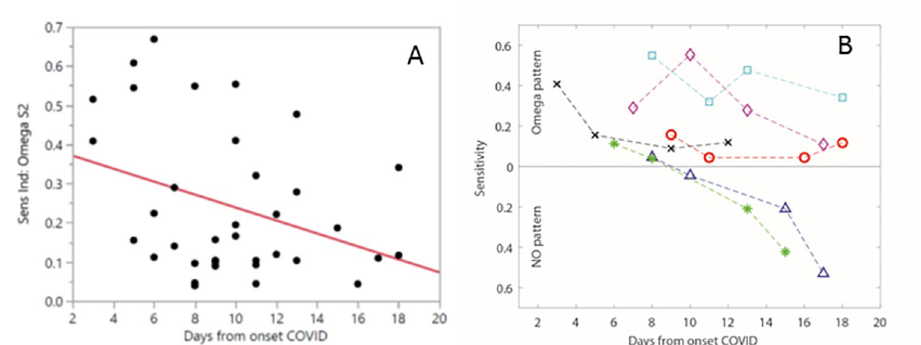
Fig 4. Amplitude of omega pattern over COVID course. A . The S2 peak as described previously measured amplitude of omega pattern. Plotting amplitude of S2 by days from COVID-19 onset defined as either day of first symptoms if patient able to provide or as days from first positive test if unable to determine symptom onset (R 2 = 0.12, p = 0.04). B . For select patients requiring mechanical ventilation over 10 days, amplitude of omega is plotted over days from COVID